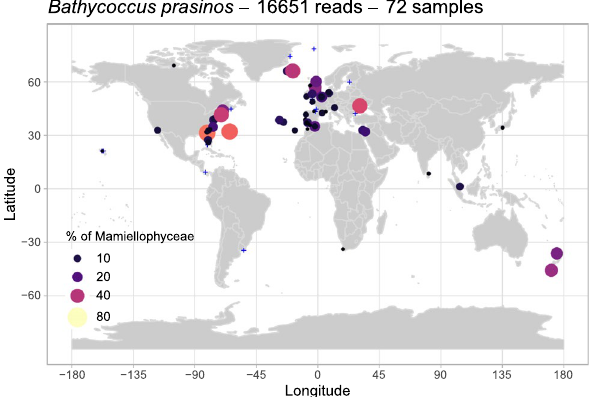
Figure 6. Distribution of the major Bathycoccus ASV for OSD2014 (LGC). Legend as in Fig. 3. A zoomed-in map of European waters is provided in Fig. S6.